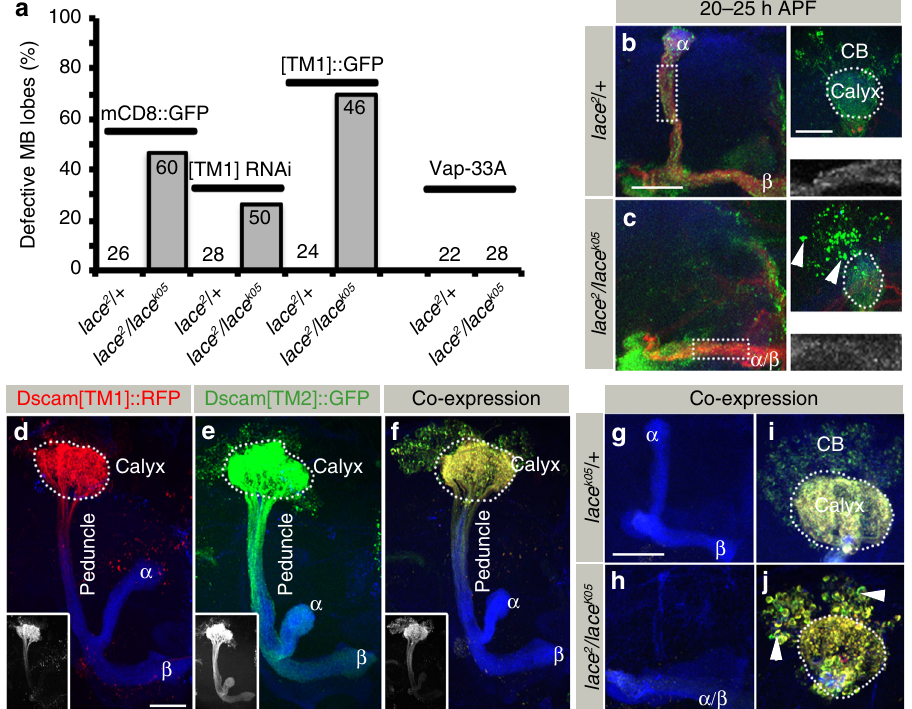
Fig. 7 Dscam[TM1] interferes with Dscam[TM2] function in SPT mutant MB neurons. a Percentage of defective MB lobes in different indicated genetic backgrounds. In SPT mutants, knocking-down of Dscam[TM1] and expressing Vap33 using Dscam-Gal4 reduces axonal targeting defects while overexpression of Dscam[TM1] enhances it. Numbers on the bars represent number of MB analyzed. b , c Distribution of Dscam[TM2]::GFP at 20 – 25 h APF in the MB of lace 2 / + ( b ) and lace 2 /lace k05 ( c ) expressed using 201Y-Gal4. While images b , c represent the axonal half of the MB, the corresponding somato-dendritic area is represented in right upper insets. The white dotted rectangle represents the Dscam[TM2]::GFP distribution in the axons, zoomed in and shown in the right lower inset. Green: Dscam[TM2]::GFP, Red: FasII, Blue: N-Cad. Arrowheads indicate somatic aggregates of Dscam. n ( b ) = 14, n ( c ) = 12. d – f MB expressing Dscam[TM1]::RFP ( d ), Dscam[TM2]::GFP ( e ) and Dscam[TM1]::RFP + Dscam[TM2]::GFP ( f ) using a α / β neuron-speci fi c Gal4 (R65G04-Gal4). Insets show single channel fl uorescence of Dscam[TM1] ( d ) /Dscam[TM2] ( e ) /Dscam [TM2] ( f ). n ( d ) = 26, n ( e ) = 26, n ( f ) = 28. g – j On expressing Dscam[TM1]::RFP (Red) with Dscam[TM2]::GFP (green) in lace k05 / + ( g , i ) and lace 2 /lace k05 ( h , j ) background with α / β speci fi c Gal4 (R65G04-Gal4), Dscam[TM2] fails to localize to axons. n ( g , i ) = 28, n ( h , j ) = 30. d – j Green: Dscam[TM2]::GFP, Red: Dscam[TM1]::RFP, Blue: FasII, Arrowheads indicate somatic aggregates. Scale Bar: 25 μ